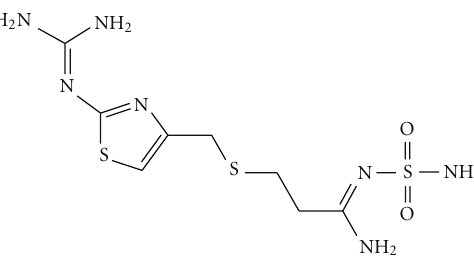
Figure 1: Structure of